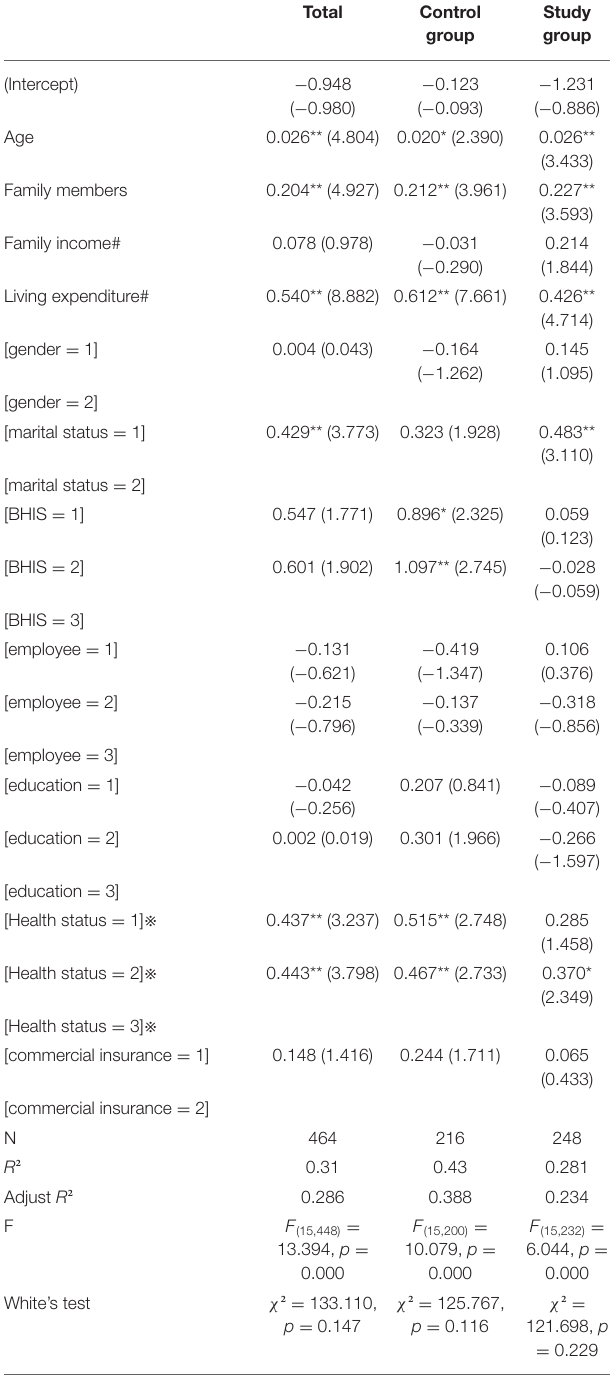
TABLE 4 | Group regression model results for the impacts of actual health cost. Total Control